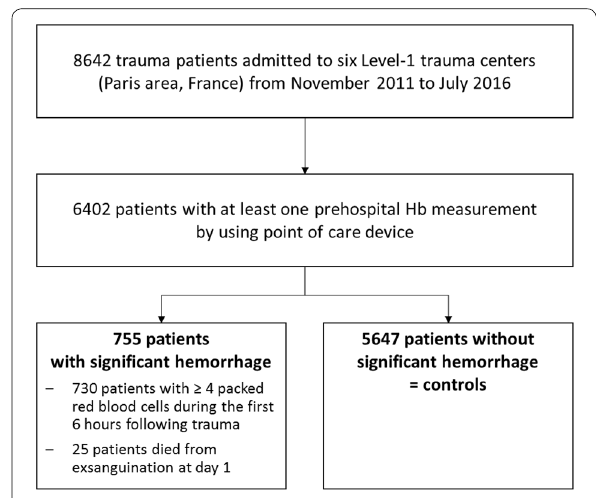
Fig. 1 Flow diagram of the